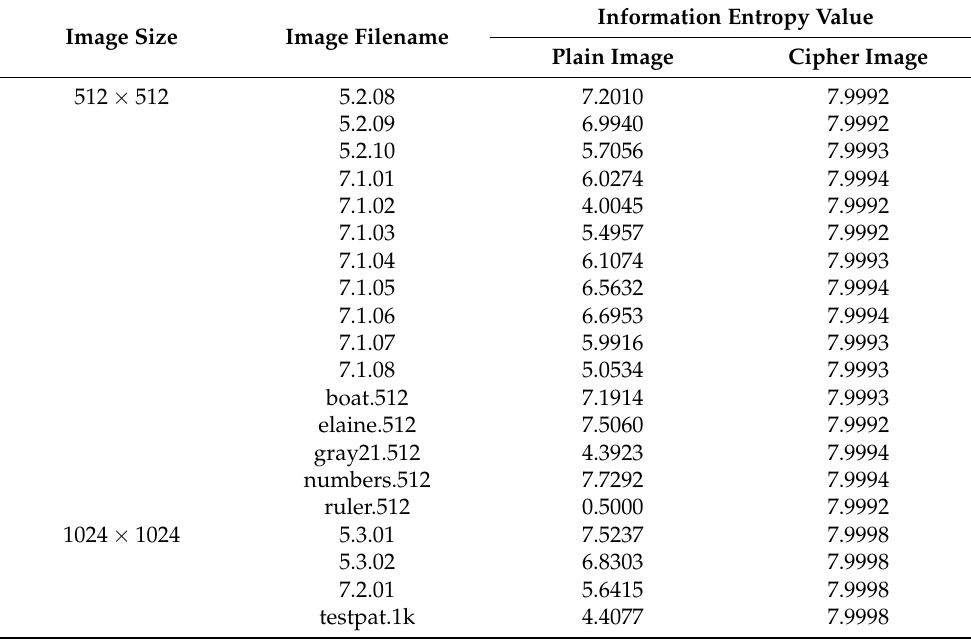
Table 6. Information entropy values of commonly used test images and corresponding cipher images generated by IEA-IF-DLT.